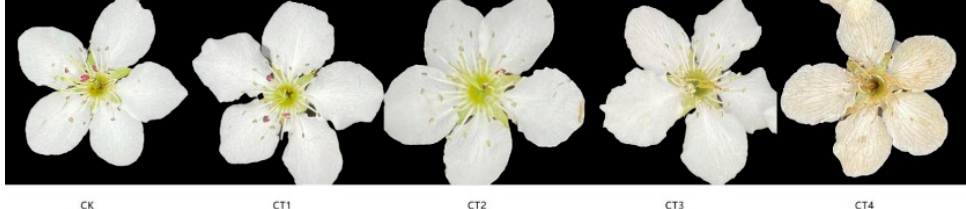
Figure 1. Comparison of ‘Jinguang’ pear flower organ condition after 4 h of treatment at 18 °C (CK), 2 ◦ C (CT1), 0 ◦ C (CT2), − 2 ◦ C (CT3), or − 4 ◦ C 2 °C (CT1), 0 °C (CT2), − 2 °C (CT3), or − 4 °C (CT4).